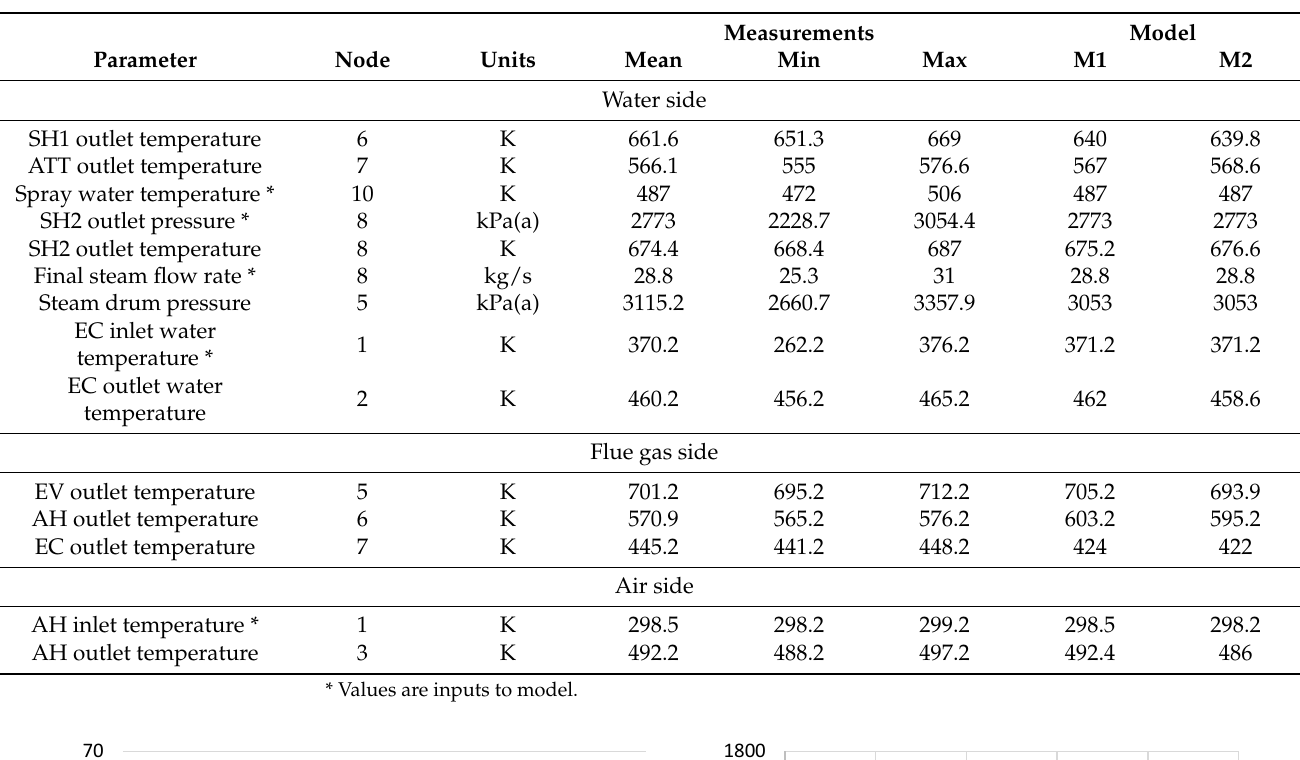
Table 8. Comparison between measured and calculated water, flue gas and air values for industrial- scale biomass-fired boiler model for 100% load case.